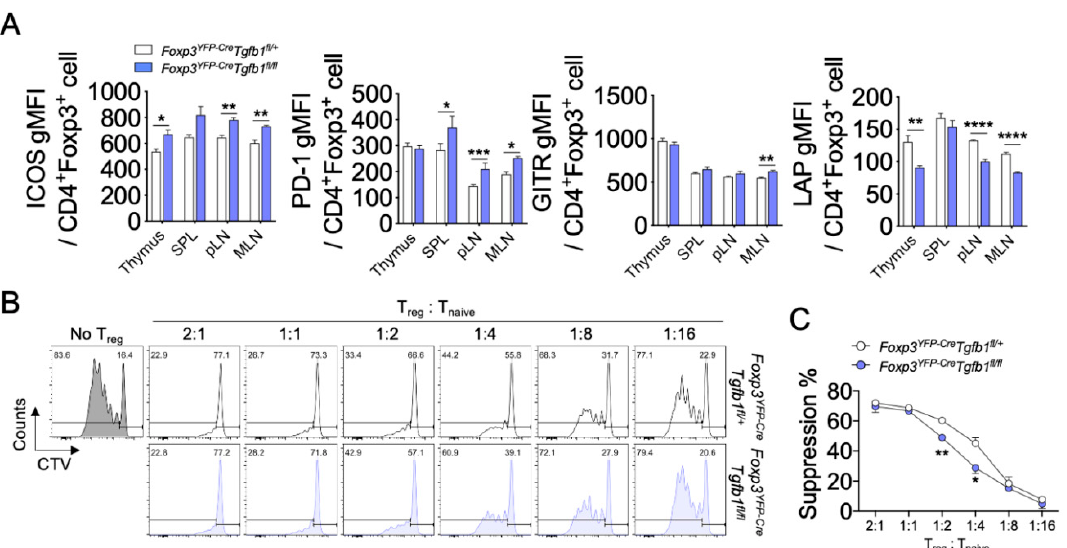
Figure 2. Suppressive capacity and cytokine production of TGF- β 1-deficient Treg cells. ( A ) Expression of ICOS, PD-1, GITR, and LAP in CD4 + Foxp3 + cells from the thymus, SPL, pLN, and MLN ( n = 4). ( B ) Treg cell suppression assay. Sorted Treg cells (CD45.2 + ) from Foxp3 YFP-Cre Tgfb1 fl/+ and Foxp3 YFP-Cre Tgfb1 fl/fl mice were cultured with CellTrace Violet (CTV)-labeled naïve T cells (CD45.1 + ) and irradiated splenocytes in the presence of anti-CD3 ε . The percentages of divided T cells are shown in each histogram plot. ( C ) Graph depicting the percentage of suppression among gated CD45.1 + cells. Data are representative of three ( B , C ) or four ( A , D ) independent experiments. * p ≤ 0.05, ** p ≤ 0.01, *** p ≤ 0.001, and **** p ≤ 0.0001 based on two-tailed Student’s t -test.